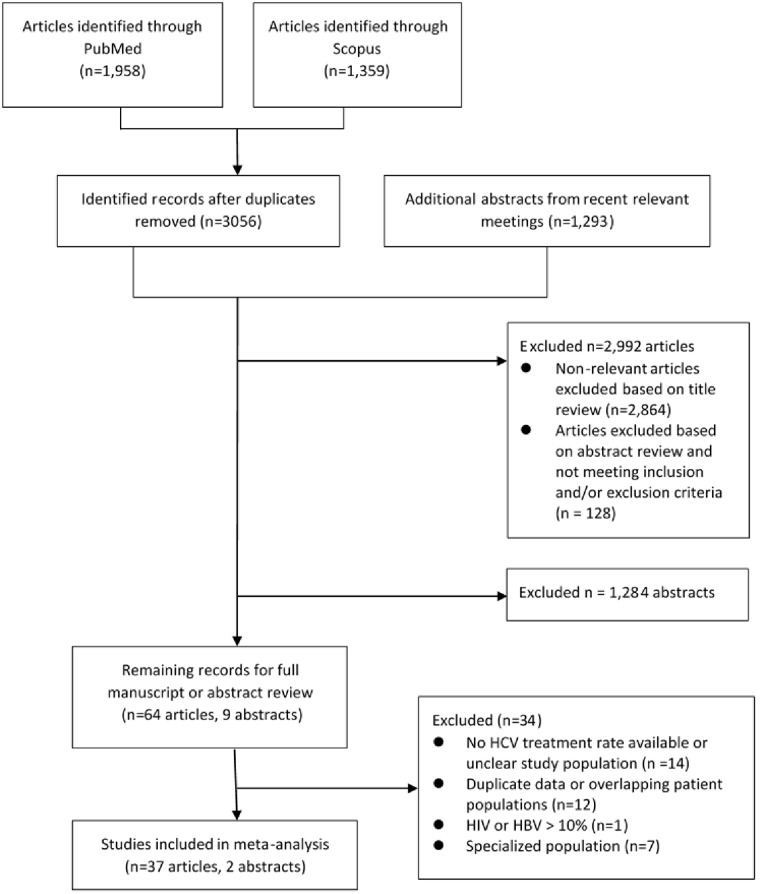
PRISMA flow diagram.